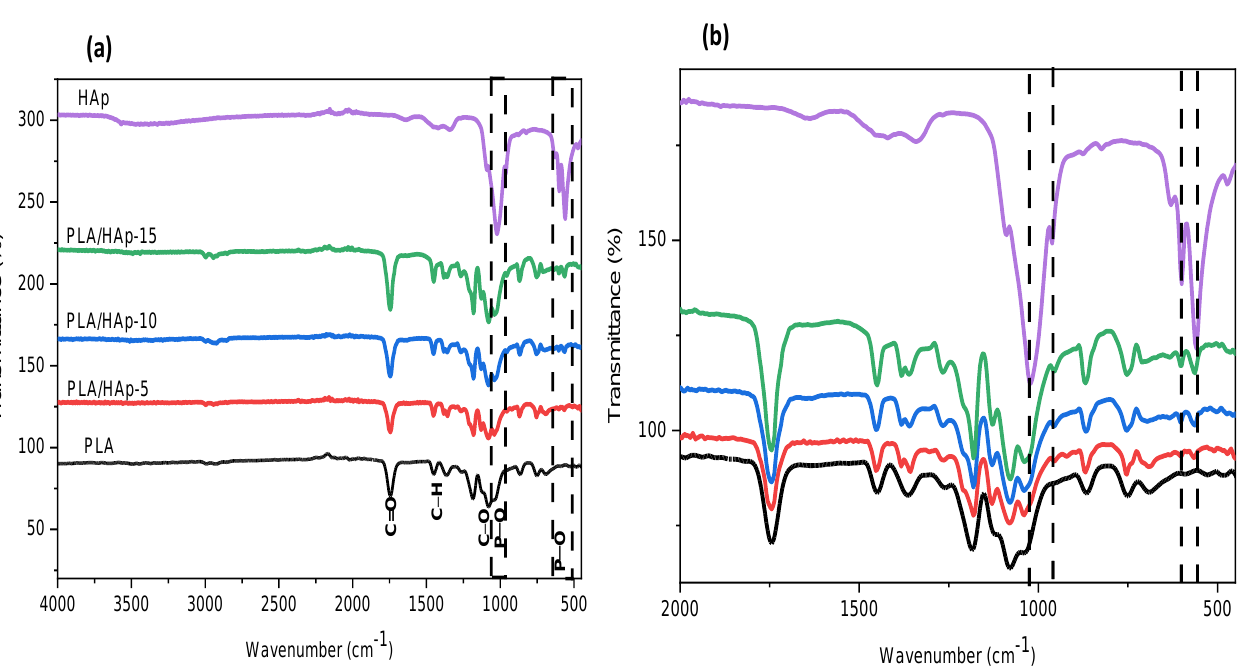
Figure 7. FT-IR spectra of neat PLA and PLA/HAp composites at various filler content, i.e., 5, 10 and 15 wt%, recorded in the regions: ( a ): 4000 – 400 cm −1 and ( b ): 2000 – 500 cm −1 .